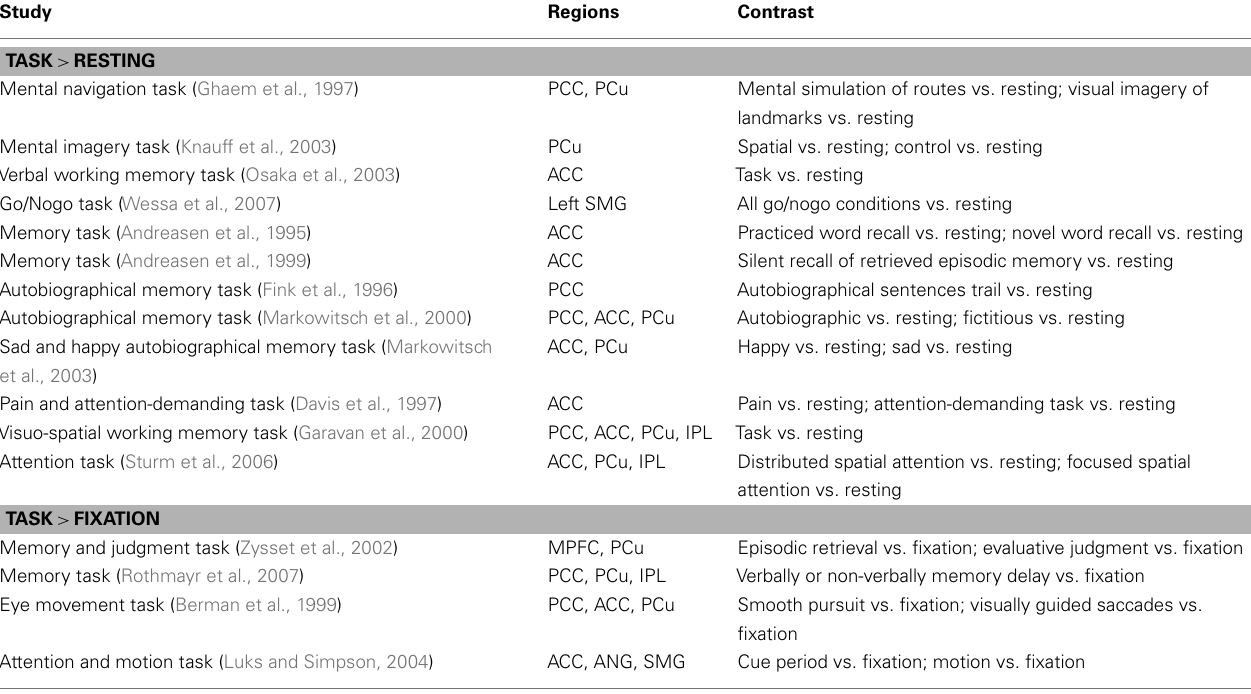
Table 1 | Studies showing that tasks elicit activation in the DMN compared to resting or passive fixation. Study Regions